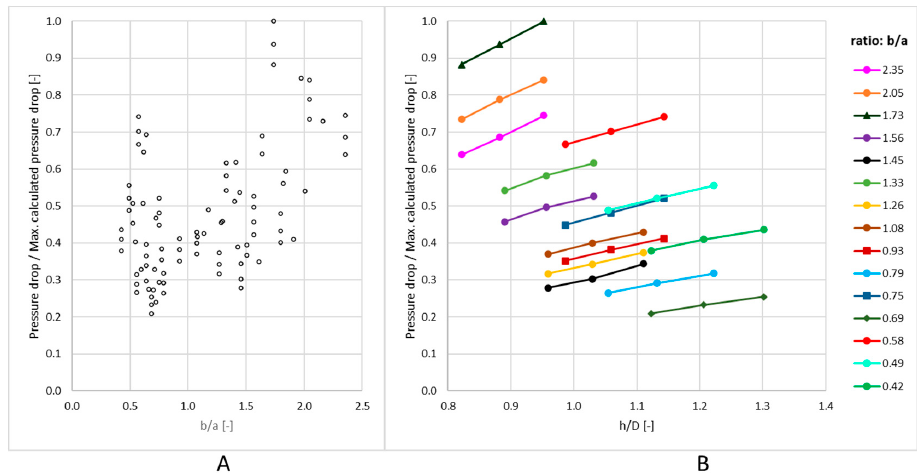
Figure 11. ( A ) Pressure drop vs. b/a ratio; ( B ) Pressure drop vs. the h/D ratio. From the presented numerical testing of the aircraft separator carried out at the set boundary conditions, it follows that: